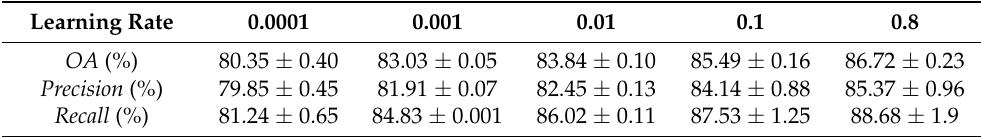
Table 4. Prediction result assessment with different learning